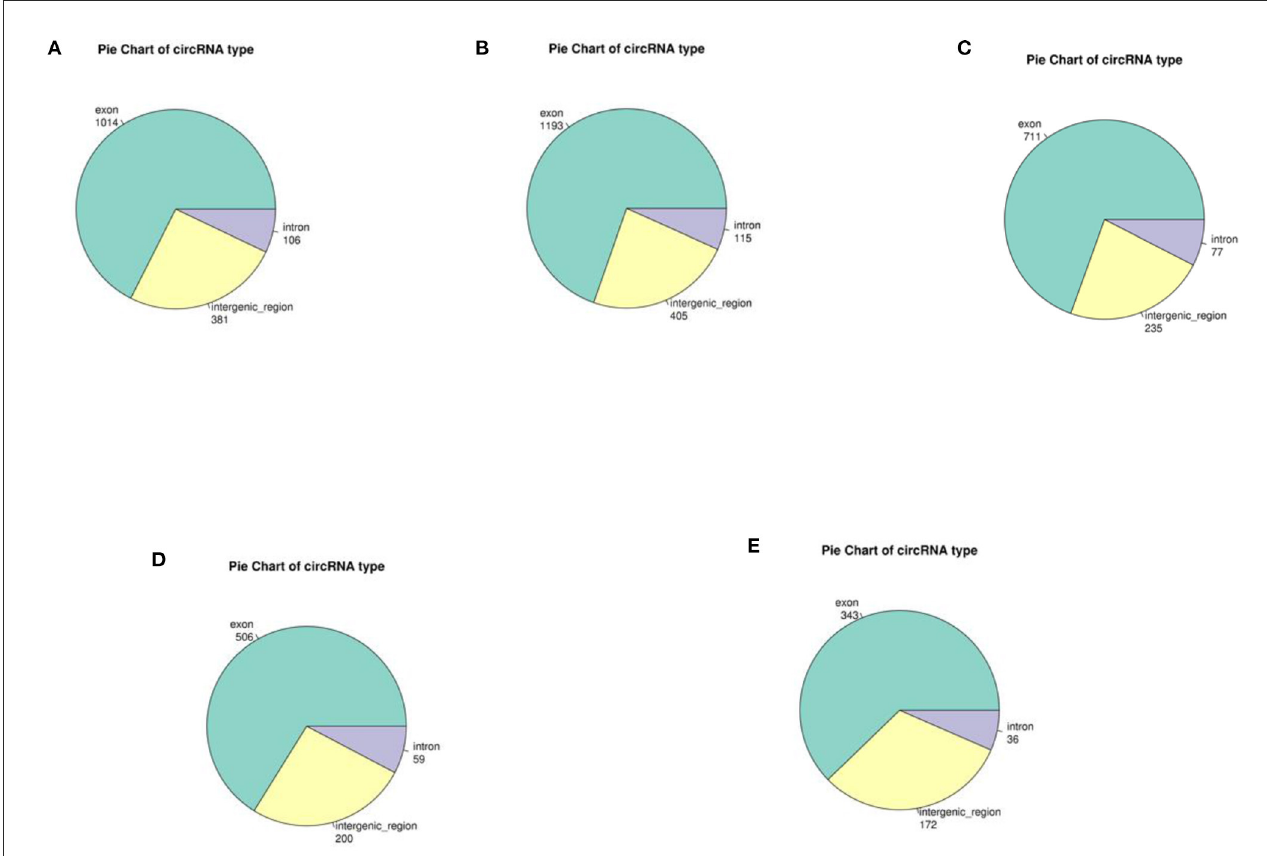
FIGURE2 Distribution diagram of circRNA sources for each sample. Different colors represent different circRNA types, and numbers represent the proportion of CircRNA types in the total. (A–C) represent the source distribution of circRNA in three yak samples; (D, E) represent the source and distribution of circRNA in cattleyak